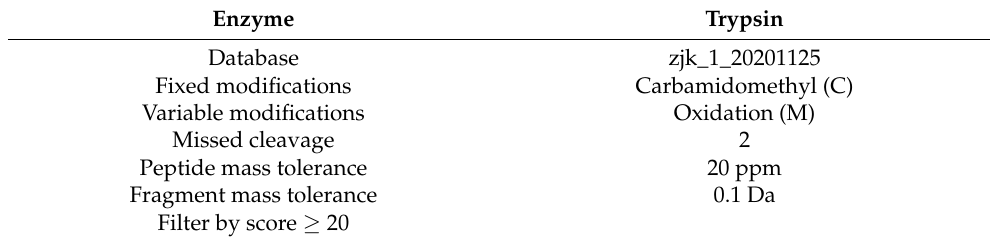
Table 1. Parameter table of database retrieval.